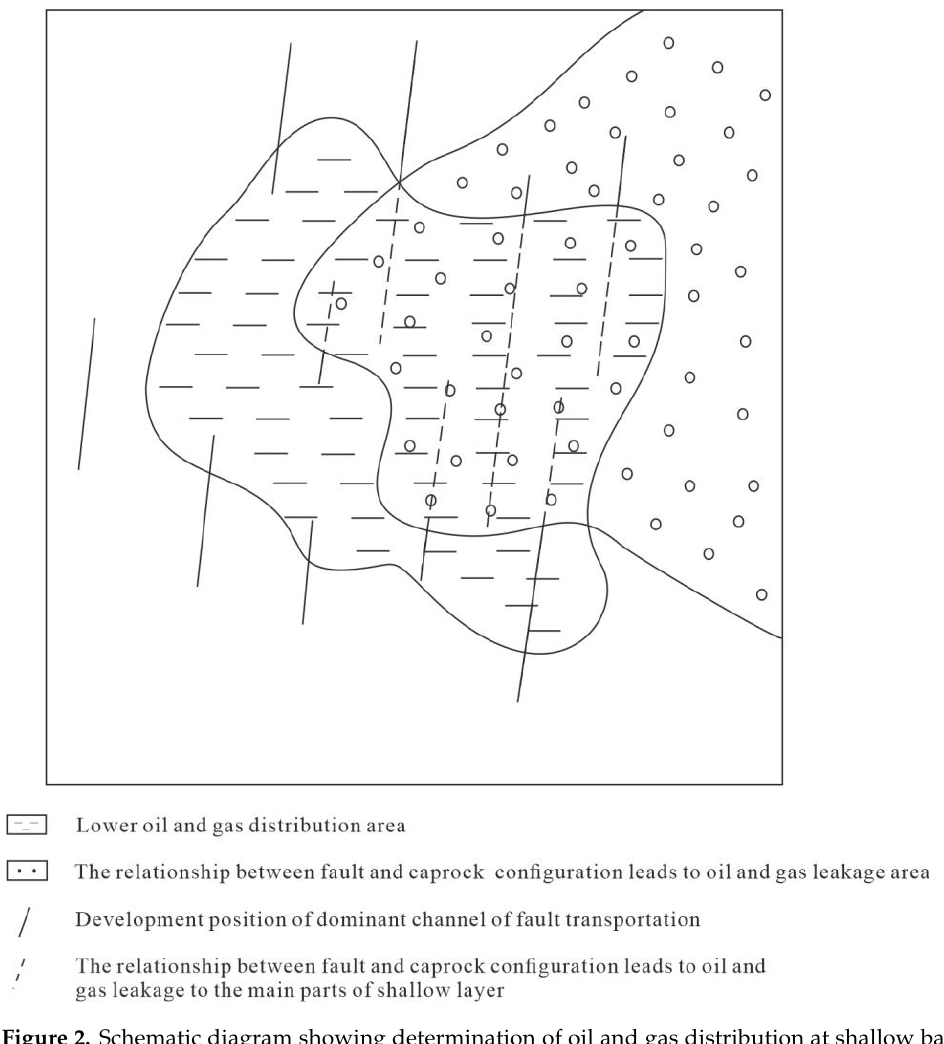
Figure 2. Schematic diagram showing determination of oil and gas distribution at shallow basins associated with fault-shale caprock configuration leakages.